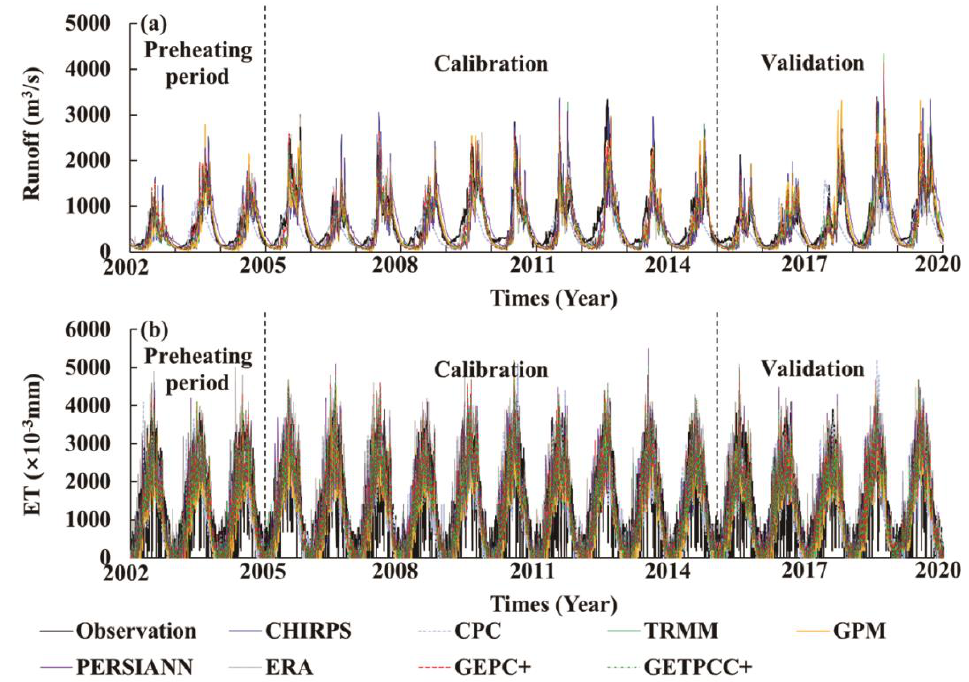
Figure 9. ( a ) The changes in observed and simulated runoff of TNH station in the preheating period ( b ) The changes in observed and simulated evapotranspiration of TNH station in the preheating